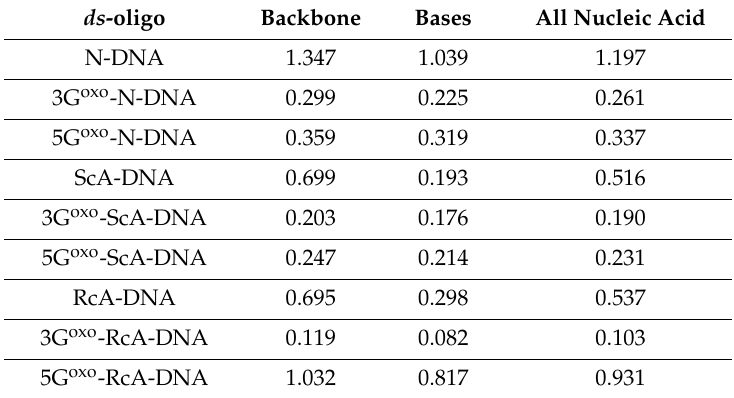
Table 7. RMSD (root-mean-square deviation) in Å of the atomic positions calculated for ds -DNAs in neutral and cation radical